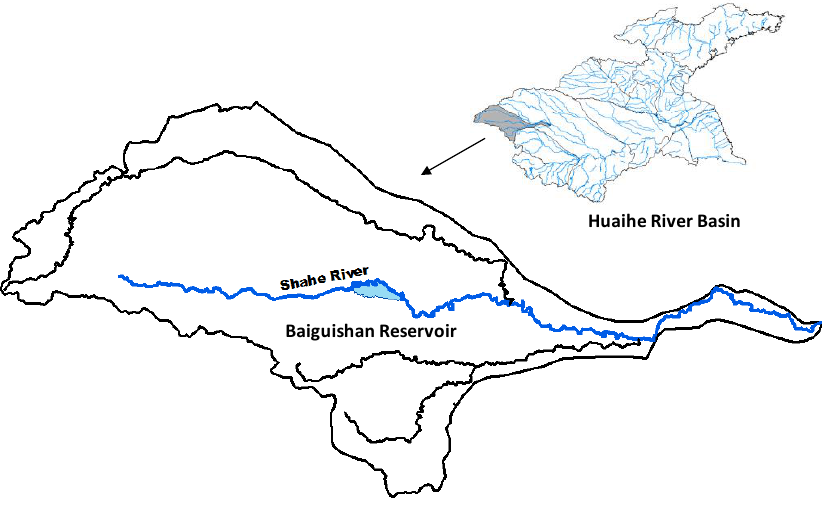
Figure 4. Location of the Baiguishan Reservoir.